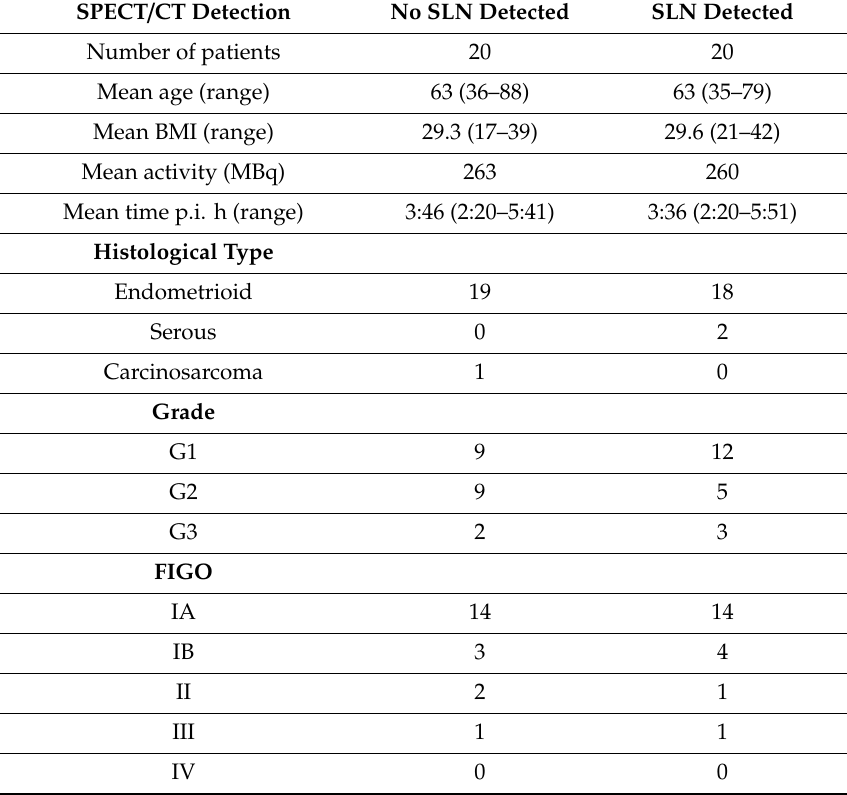
Table 1. Patient baseline